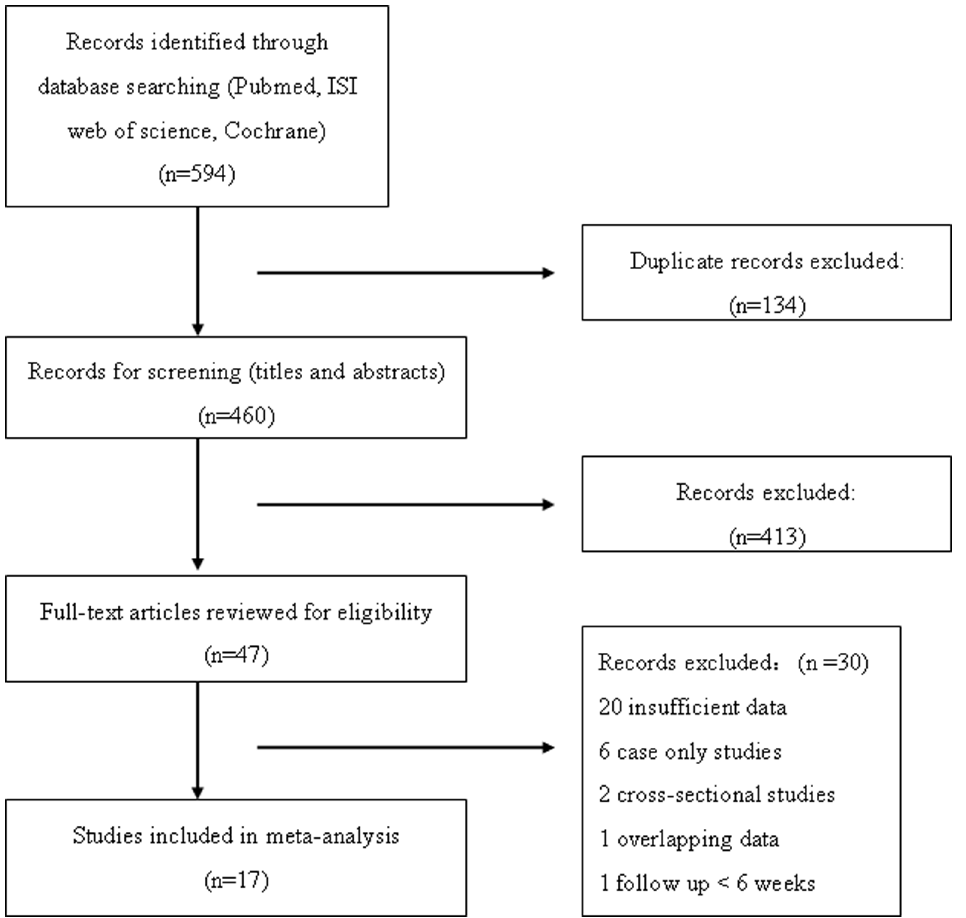
Figure 1. Flow diagram of study selection.